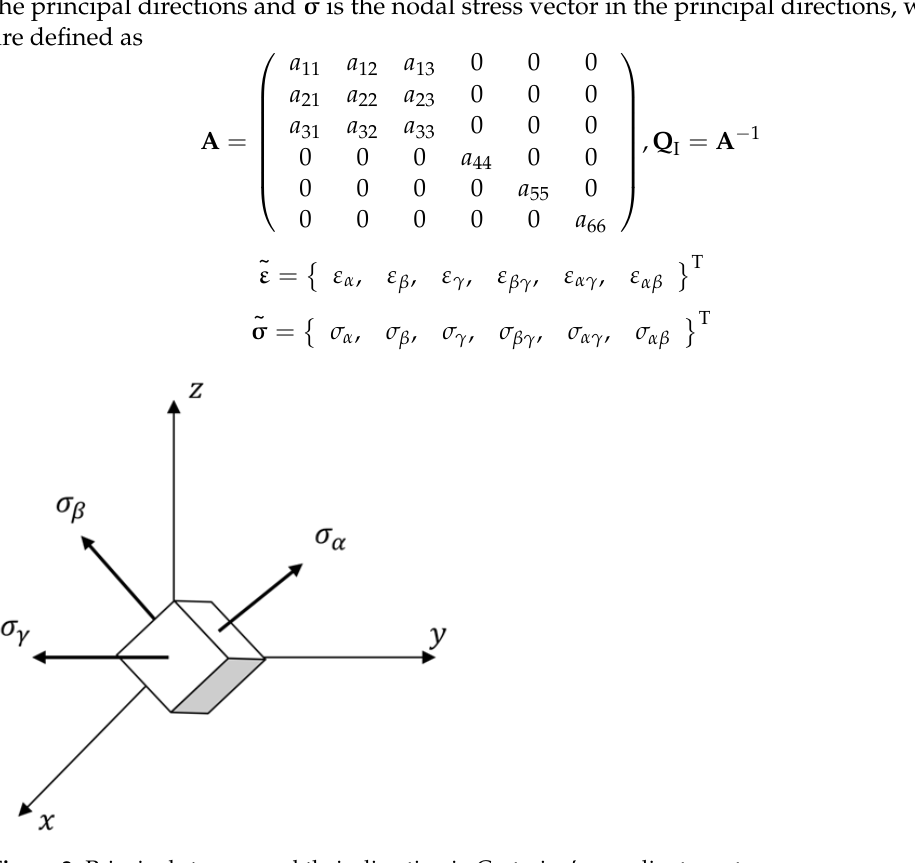
Figure 2. Principal stresses and their direction in Cartesian’s coordinate system.